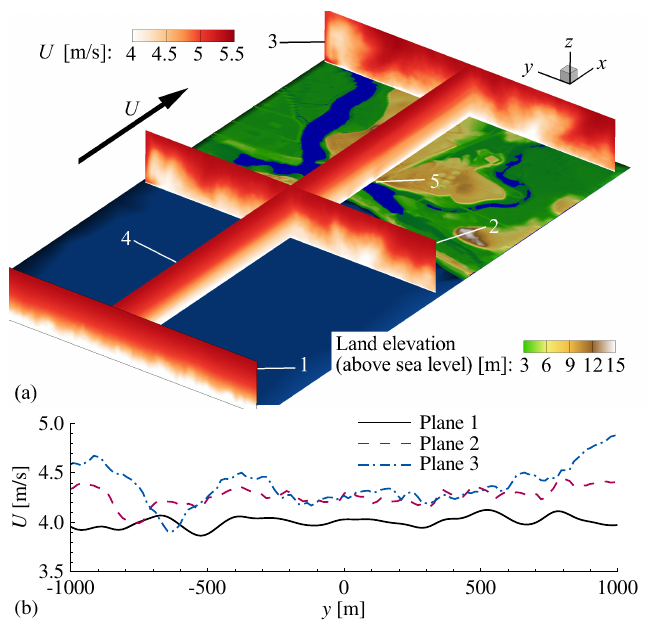
Figure 2. Time-averaged streamwise velocity U in case ESB1 (Elkhorn Slough Beach). ( a ) Contours at three y – z planes and one x – z plane; and ( b ) spanwise profiles at z = 50 m at planes 1, 2, and